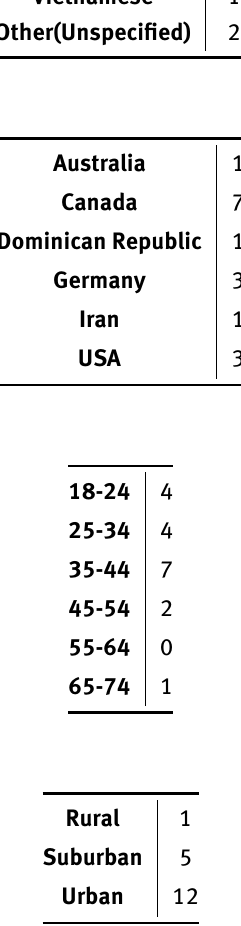
Table 5: Country of origin.